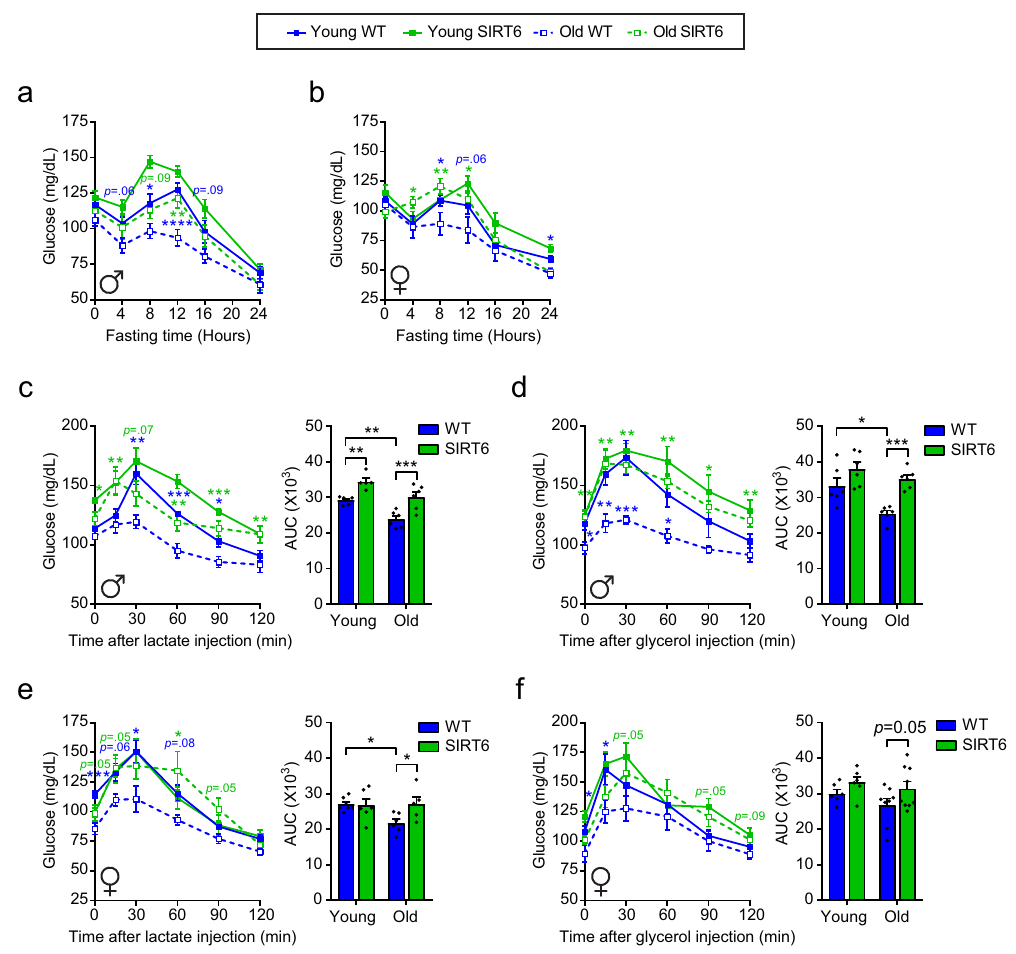
Fig. 3 SIRT6 overexpression blocks age-dependent normoglycemia and deterioration in gluconeogenesis capacity. a Blood glucose levels in young and old WT (blue) and SIRT6-tg (green) male mice at fed and fasted time points, as indicated in the graph. n = 10 young WT mice, n = 8 young SIRT6 mice, n = 7 old WT and old SIRT6 mice. b Same as ( a ), but in females. n = 8 young WT mice, n = 7 young SIRT6, old WT, and old SIRT6 mice. c Lactate tolerance test in 6 h-fasted male mice; n = 6 young WT, old WT, and old SIRT6 mice, n = 5 young SIRT6 mice. d Glycerol tolerance test in 6 h-fasted male mice; n = 6 mice per group. e Lactate tolerance test in 6 h-fasted female mice; n = 6 old WT, young SIRT6, and old SIRT6 mice, n = 7 young WT mice. f Glycerol tolerance test in 6 h-fasted female mice; n = 6 young WT and young SIRT6 mice, n = 8 old WT mice, n = 9 old SIRT6 mice. The area under the curve (AUC) for each tolerance test is shown on the right. For all panels, ages were 4 – 6 (young) and 22 – 24 (old) months. Statistical signi fi cance was calculated using three-way ANOVA with Sidak ’ s post hoc for line graphs, and two-way ANOVA with Fisher ’ s LSD method for bar graphs. Young WT (* in blue) or old SIRT6 (*in green) vs. old WT. In all panels, values are mean ± SEM. Exact p -values are reported in the Source Data fi le. * p < 0.05, ** p < 0.01, *** p < 0.001, **** p <